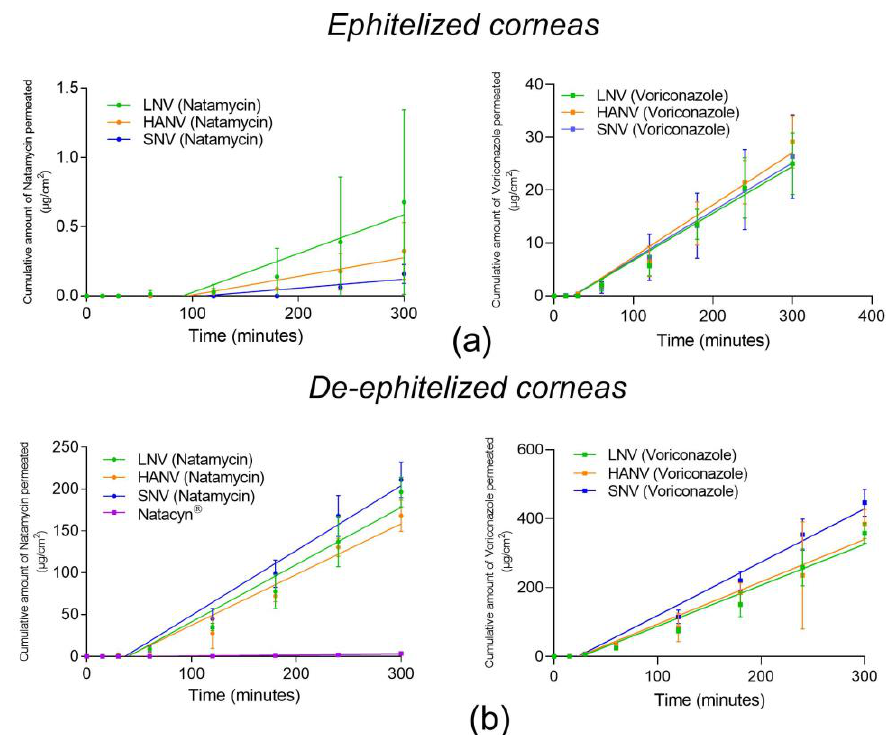
Figure 8. Cumulative amount of drug permeated ( µ g/cm 2 ) through epithelized ( a ) bovine and de-epithelized ( b ) corneas for natamycin (left) and voriconazole (right).